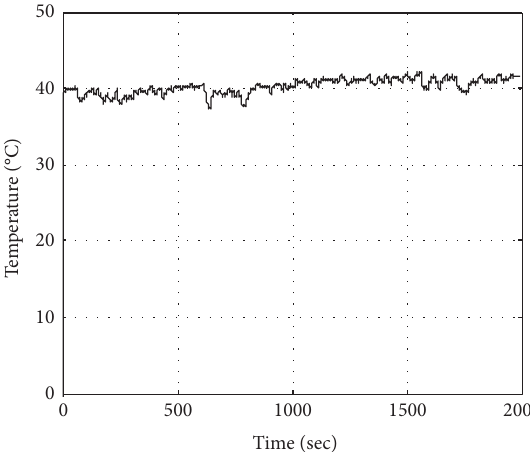
Figure 19: Evolution of temperature.